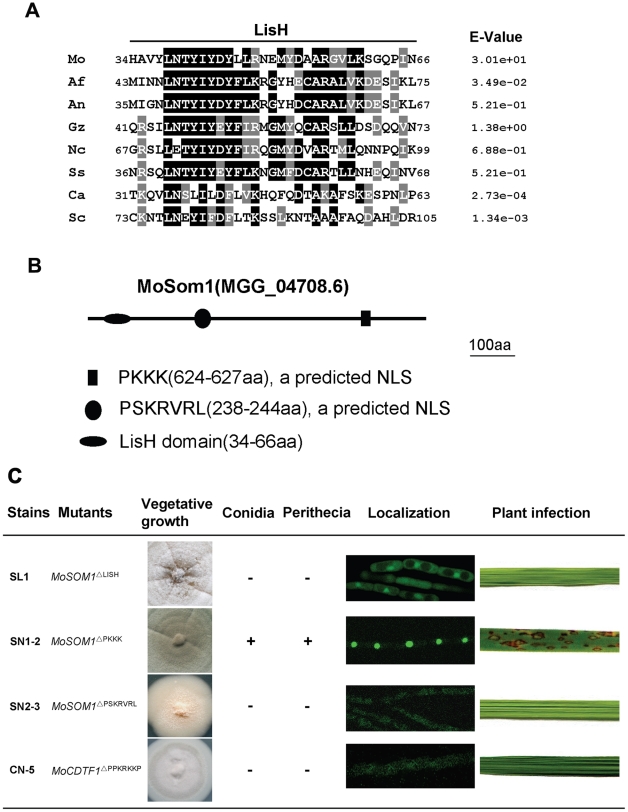
Functional analysis of putative LisH domain and nuclear localization sequences of MoSom1.(A) Sequence alignment of the LisH domain between Magnaporthe oryzae MoSom1 and other regulatory proteins. Identical residues are shaded in black and conserved residues are shaded in gray. Abbreviations correspond to species names. The fungal species, proteins and GenBank accession numbers are: Mo, M. oryzae MoSom1_XP_362263; Af, Aspergillus fumigatus putative Som1_XP_746706; An, A. nidulans putative OefA_AAW55626; Gz, Gibberella zeae putative Som1_XP_382826; Nc, Neurospora crassa putative Som1_AAF75278; Ss, Sclerotinia sclerotiorum putative Som1_XP_001598877; Ca, Candida albicans Flo8_AAQ03244; Sc, Saccharomyces cerevisiae Flo8_DAA07769. (B) Position of LisH domain and two predicted nuclear localization sequences (NLSs) in MoSom1 protein. (C) Functional analysis of domains. Like Δmosom1 mutants, deletion of LisH domain of MoSOM1 resulted in pleiotropic defects. The predicted NLS of PSKRVRL but not PKKK was required for MoSom1 localization to the nucleus and its function. The predicted NLS (PPKRKKP) was also crucial for the function and localization of MoCdtf1 protein. +, normal asexual or sexual sporulation; -, not any conidia or perithecia. The LisH domains were predicted at: http://smart.embl-heidelberg.de/; The NLSs were predicted at: http://psort.hgc.jp/form2.html.